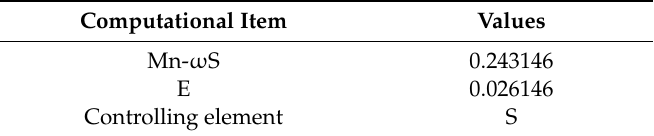
Table 4. Controlling element calculation of MnS in non-oriented electrical steel.